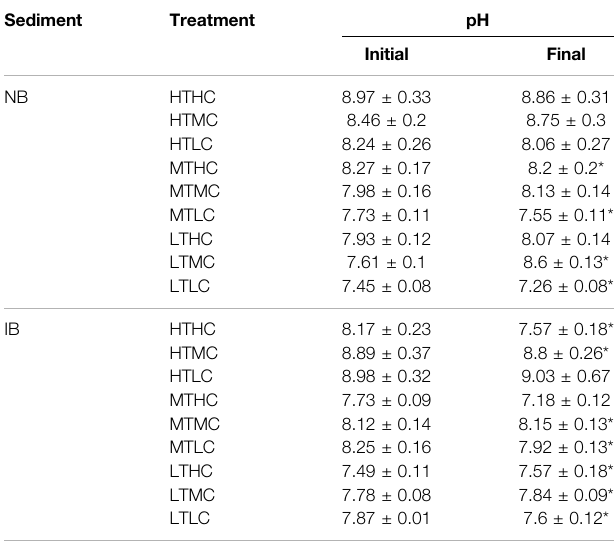
TABLE 4 | pH values by sediment type (NB and IB) and treatment type at the beginning and end of the experiments. Sediment